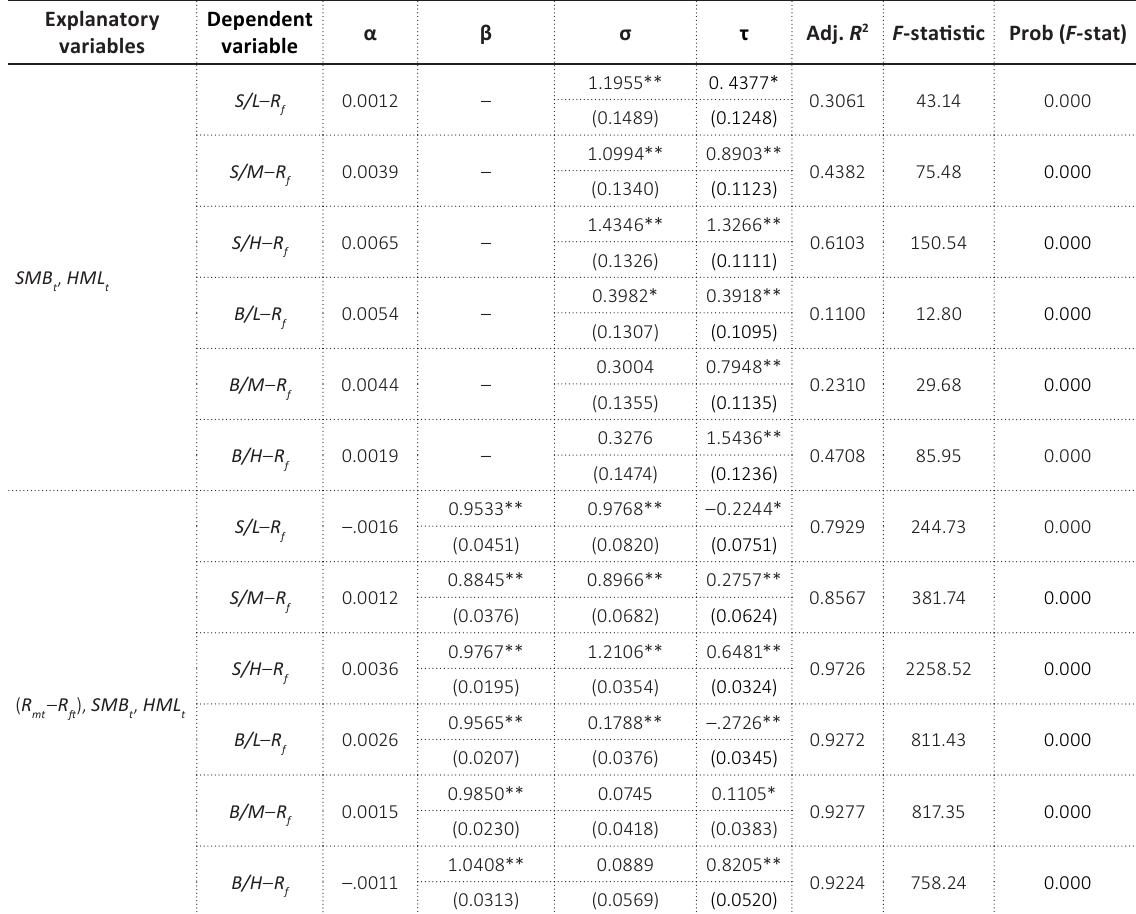
Table 2 (cont.). Test results for Fama-French three-factor model in the Indian stock market Explanatory